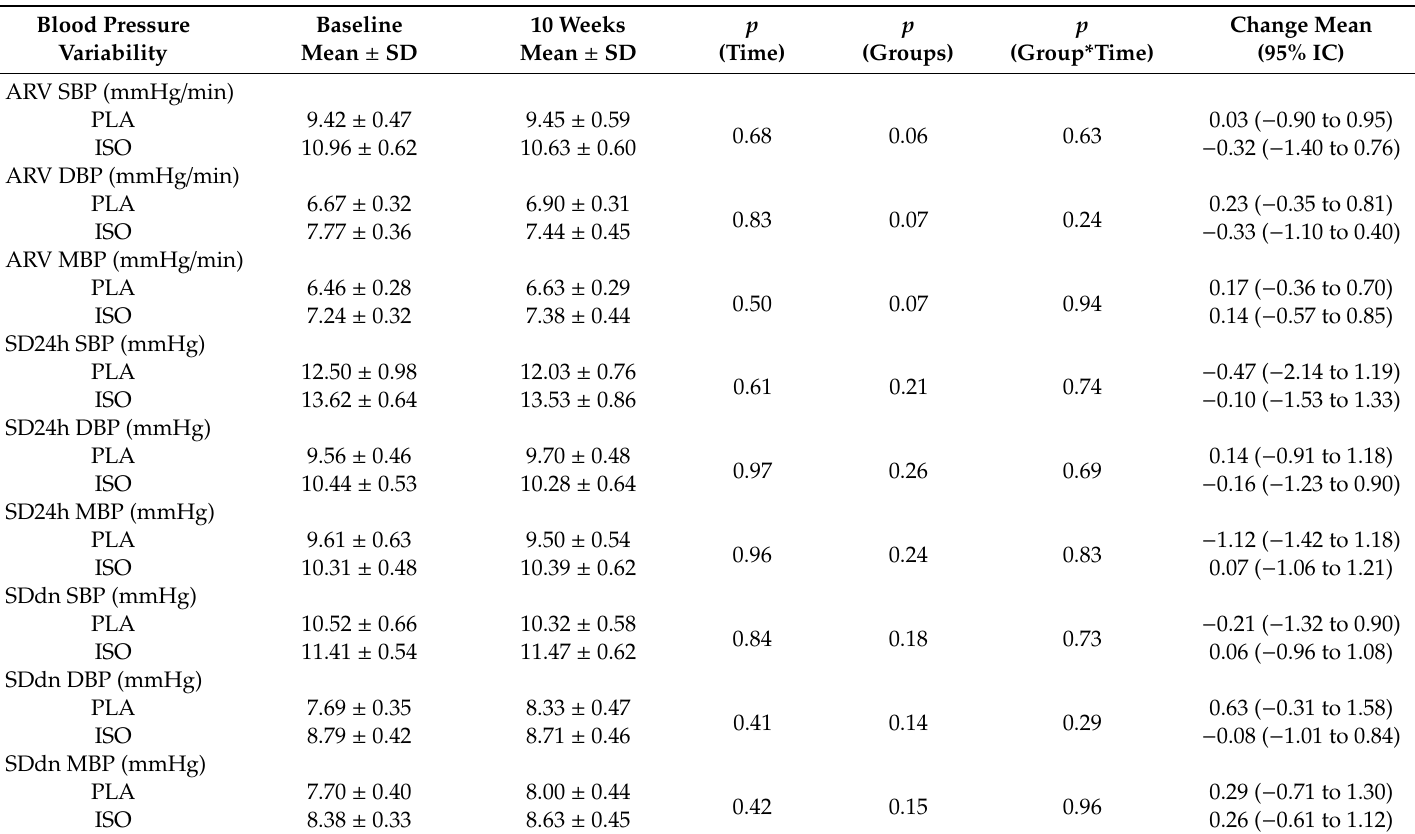
Table 3. Intention-to-treat analysis of ambulatory blood pressure variability evaluated before (baseline) and after 10 weeks of exercise training in both placebo + exercise (PLA) and Isoflavone + exercise (ISO)